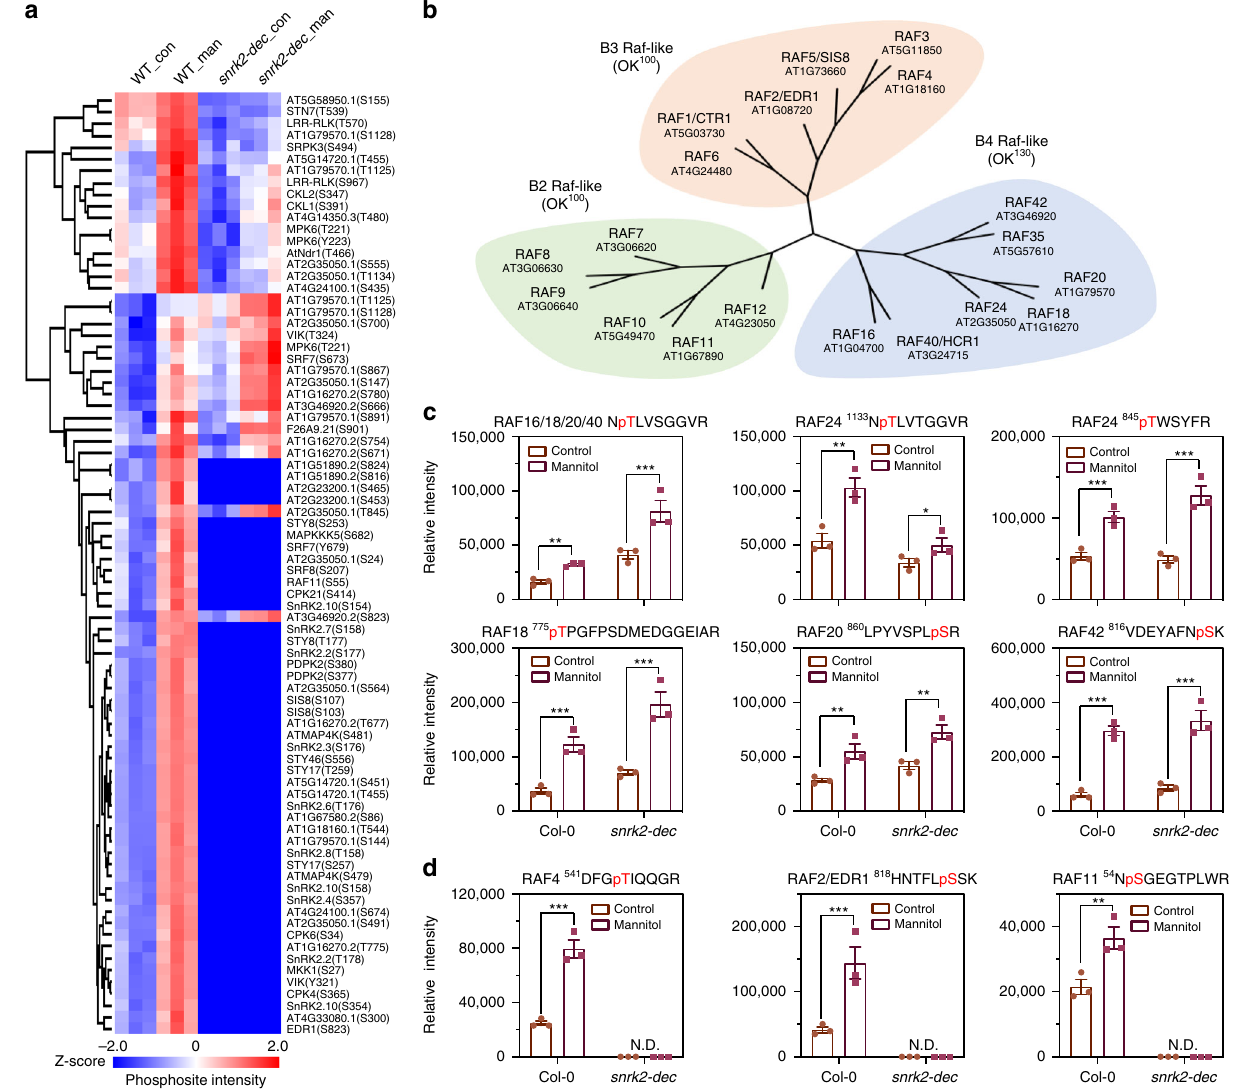
Fig. 2 Identi fi cation of OKs by phosphoproteomics. a Heat map showing relative intensity of phosphosites from protein kinases in control and mannitol- treated wild-type and snrk2-dec mutant seedlings. b Phylogenetic tree of B2, B3, and B4 RAFs. c Quantitative analysis of phosphopeptides from B4 Raf-like kinases in seedlings with or without mannitol treatment. Error bars, SEM ( n = 3). Student ’ s t -test, * p < 0.05, ** p < 0.01, *** p < 0.001. d Quantitative analysis of phosphopeptides from B2 and B3 Raf-like kinases in seedlings with or without mannitol treatment. Two-tailed paired t -tests, ** p < 0.01, *** p < 0.001. N.D., not identi fi ed in the samples. Source data are provided in Supplementary Data 4 and